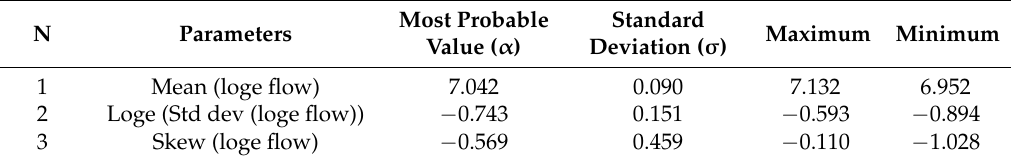
Figure 3. Flood frequency curve at An Khe gauge [34]. Table 2. Parameter values of LP-III distribution (vector β ) and ranges of acceptable LP-III parameters at An Khe gauge.